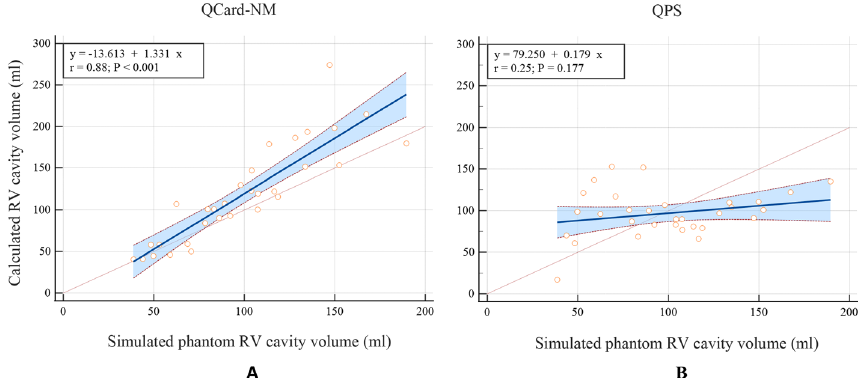
Fig. 10 Scatter plots of the calculated volumes with A QCard-NM and B QPS versus the simulated actual RV cavity volume in phantom study. Linear regression trend line with 95% CI is exhibited in blue